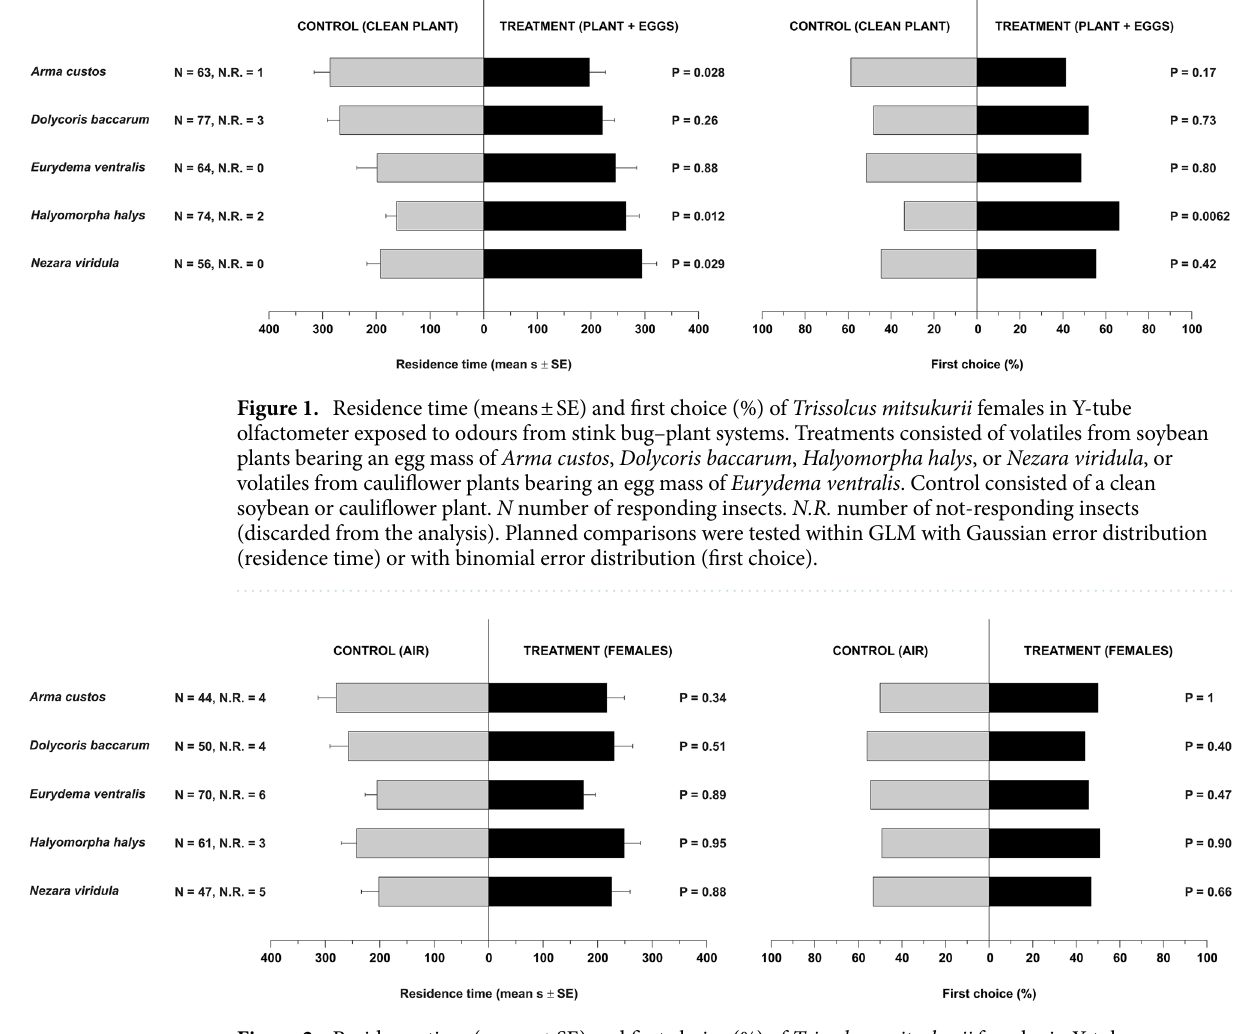
Figure 2. Residence time (means ± SE) and first choice (%) of Trissolcus mitsukurii females in Y-tube olfactometer exposed to odours from stink bug females. Treatments consisted of volatiles from females of Arma custos , Dolycoris baccarum , Eurydema ventralis , Halyomorpha halys , or Nezara viridula . Control consisted of clean air. N number of responding insects. N.R. number of not-responding insects (discarded from the analysis). Planned comparisons were tested within GLM with Gaussian error distribution (residence time) or with binomial error distribution (first